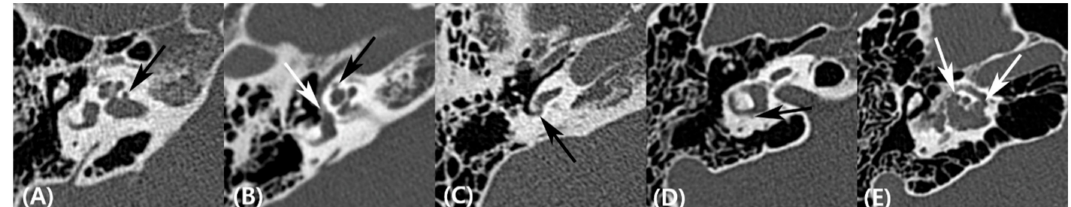
Figure 1. ( A ) Axial computed tomography (CT) image showing the presence of a focal hypodense notch connecting to the anterior wall of the internal auditory canal (IAC), designated as a cavitating lesion with IAC involvement (arrow). ( B ) Axial CT image showing otosclerotic involvement of the cochlear (black arrow) and the vestibule (white arrow). ( C , D ) Axial CT images showing retrofenestral involvement of the ( C ) round window and ( D ) the lateral semicircular canal (arrows). ( E ) Confluence between the cavitating lesion involving the IAC and cochlear involvement was demonstrated on axial CT